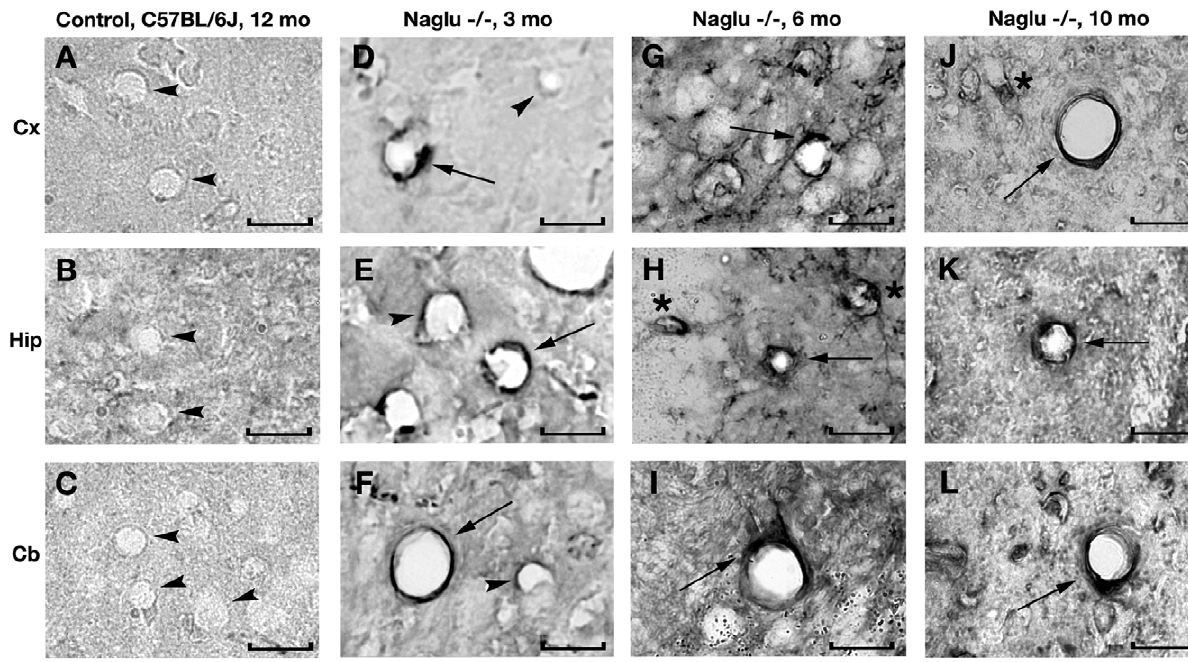
Figure 7. Immunohistochemical staining for GM3 ganglioside in the brains of Naglu mice. In the brain of control C57 BL/6J mouse at 12 months of age, GM3 ganglioside is not detected within the vascular endothelium of blood vessels ( A , B , C , arrowheads). In early symptomatic (3 month of age) Naglu mice, some endothelial cells stained positive for GM3 ( D , E , F , arrows) and some cells were negative for GM3 ( D , E , F , arrowheads). GM3 accumulation (arrows) was seen in the endothelia of numerous brain blood vessels ( G , H , I ) at late (6 months of age) and ( J , K , L ) at end stages of disease (10 months of age). Significant GM3 ganglioside accumulation was also seen in neurons (asterisks) in Naglu mice. Cx – cerebral cortex, Hip – hippocampus, Crb – cerebellum. Scale bar in A through I is 25 m m.